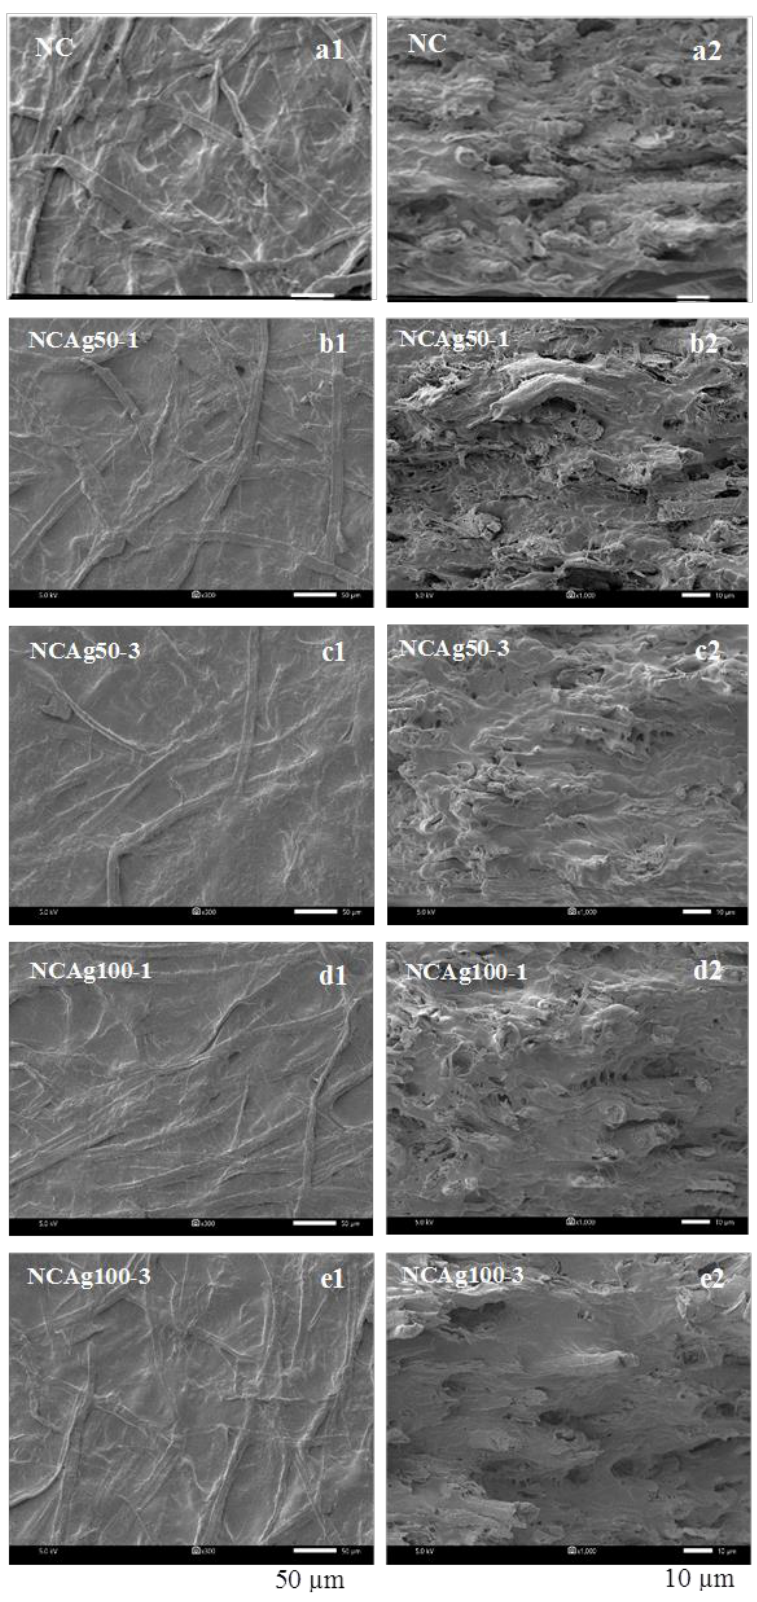
Figure 3. SEM images of surface (a1–e1), ( left ) and cross-section (a2–e2), ( right ) of NC, NCAg50, and NCAg100 films.